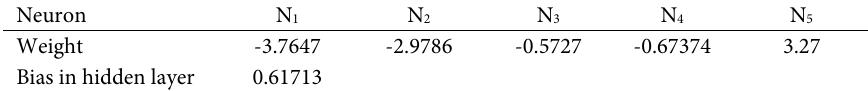
Table 5. Matrix of weights between hidden and output layers.